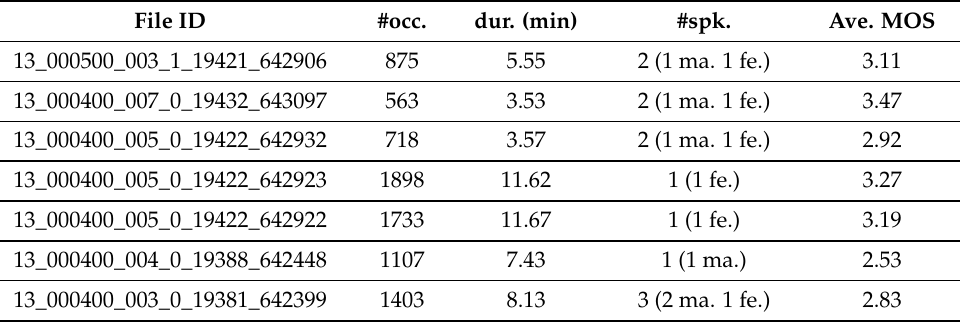
Table 3. Characteristics of the SPARL20 database, used as test data in the evaluation: number of word occurrences (#occ.), duration (dur.) in minutes (min), number of speakers (#spk.) and average MOS (Ave. MOS). These characteristics are displayed for training (train), development (dev) and testing (test)